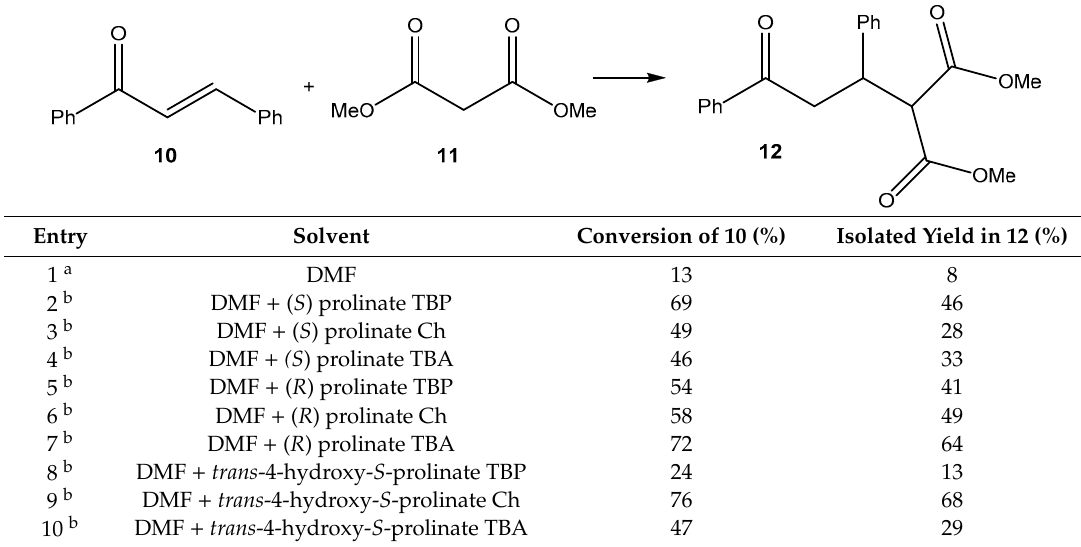
Table 2. Michael reactions under thermic conditions.